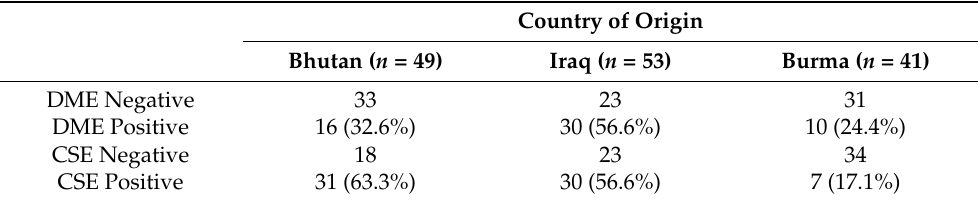
Table 1. RHS-15 case status (Positive = above RHS-15 cutscore; Negative = below RHS-15 cutscore) by country at DME (T1) and CSE